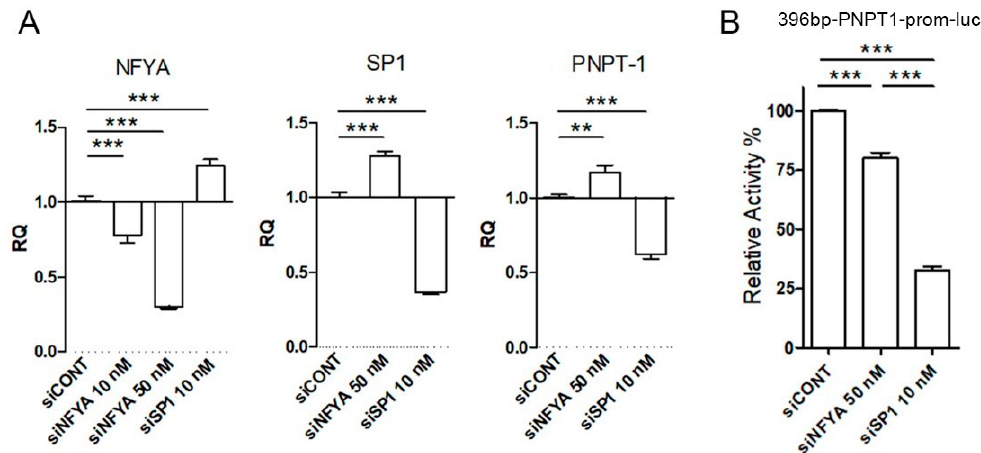
Figure 4. SP1 and NFYA expression effect on PNPT1 mRNA levels and promoter activity. ( A ) relative mRNA levels of NFYA, SP1 and PNPT1 were assessed by qPCR in HeLa cells treated with the indicated concentrations of a silencer to SP1 or NFYA (siSP1, siNFYA) or a commercial control silencer (siCONT). ( B ) HeLa cells were co-transfected with the 396 bp PNPT1 prom-luc plasmid and with the indicated silencer. The luciferase activity was measured in cell lysates and expressed as relative units respect to control cells (mean ± SD). Statistical analysis: 1 way ANOVA/Tuckey: ** p < 0.01, ***, p < 0.001; ( A ) n = 9 (3 assays on triplicated); ( B ) n = 8 (2 assays on